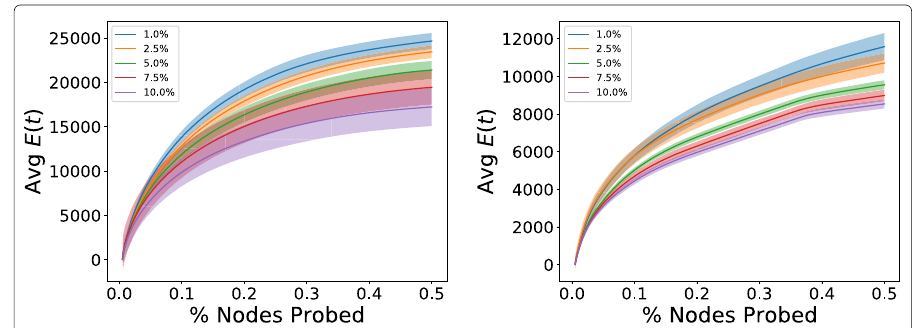
Fig. 5 Average cumulative prediction error of NOL-HTR in a BA (left) and BTER (right) synthetic network, starting at time step t = 50. Smaller initial samples result in larger prediction error, but error stabilizes over probes regardless of initial sample